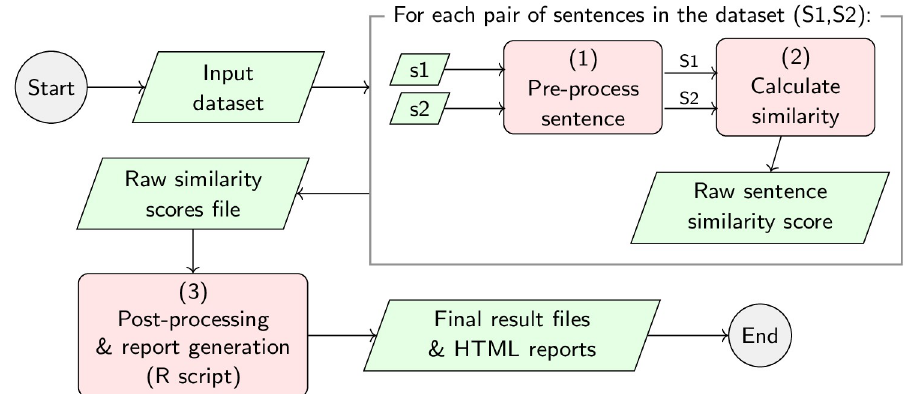
Fig 3. Detailed workflow implemented by our experiments for pre-processing the input sentences, calculating the raw similarity scores, and post-processing the results obtained in the evaluation of the biomedical datasets. This workflow generates a collection of raw and processed data files.